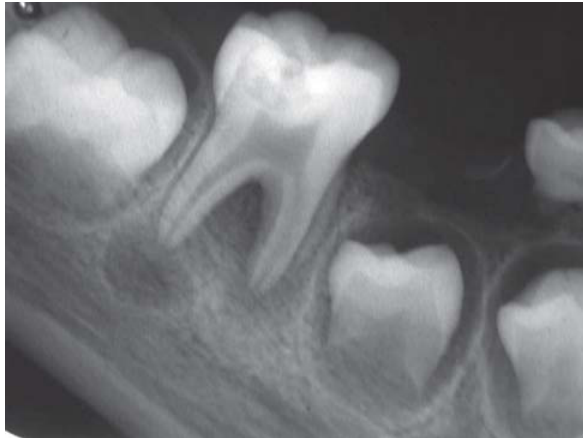
Figure 11- Endodontic treatment performed